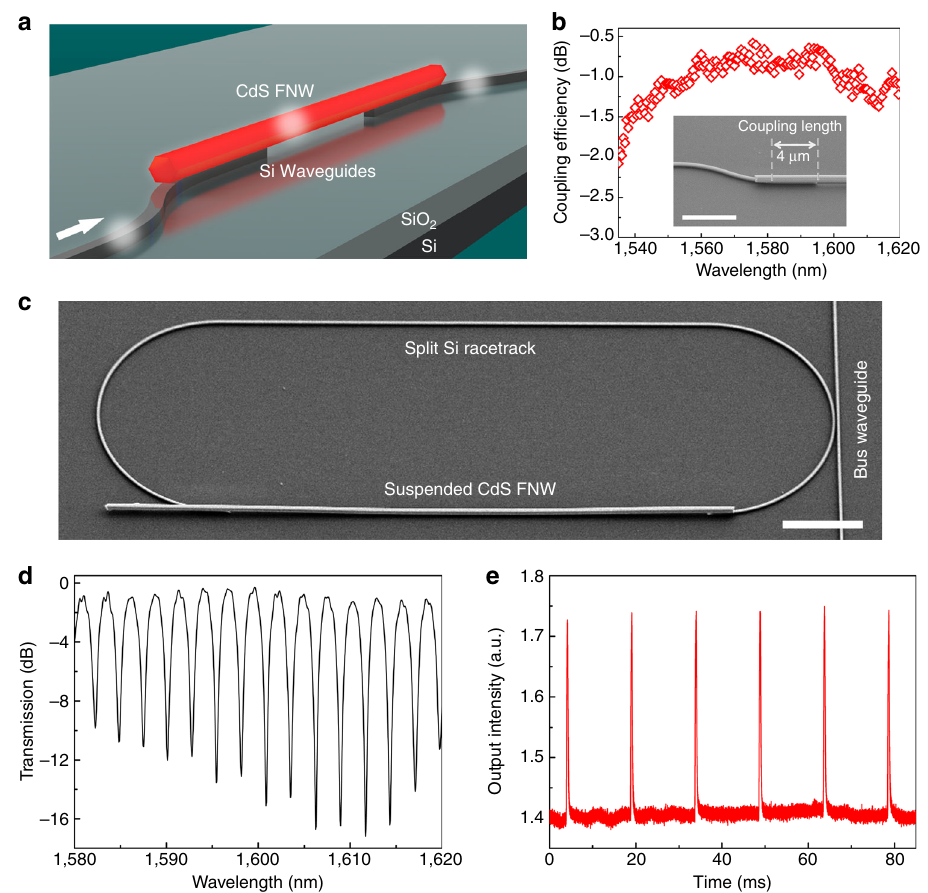
Fig. 3 Integration of a FNW into a silicon chip using a vertical coupling scheme. a Schematic diagram of the vertical coupling structure suspending a FNW across two SWs collinearly. The white arrow indicates the direction of light propagation. b Wavelength-dependent coupling ef fi ciency of a 770-nm-diameter CdS FNW with a 320-nm-width SW. Inset shows an SEM image of the coupling structure with a pre-de fi ned coupling length